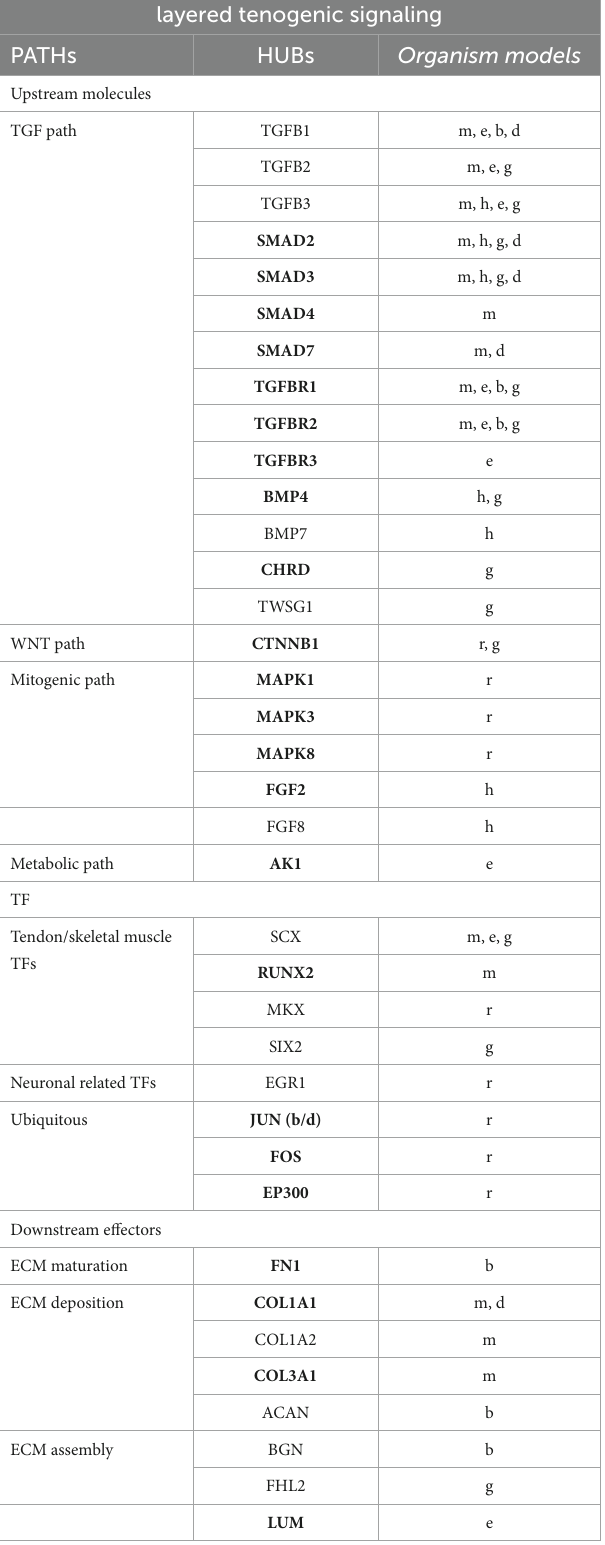
TABLE 5 Representation of the hubs of the Enriched TendonNETs organized into the multi-layered tenogenic signaling and classified for organism model. Degree of inter specie-specific conservation of hubs of the Enriched TendonNETs classified into the three multi layered tenogenic signaling